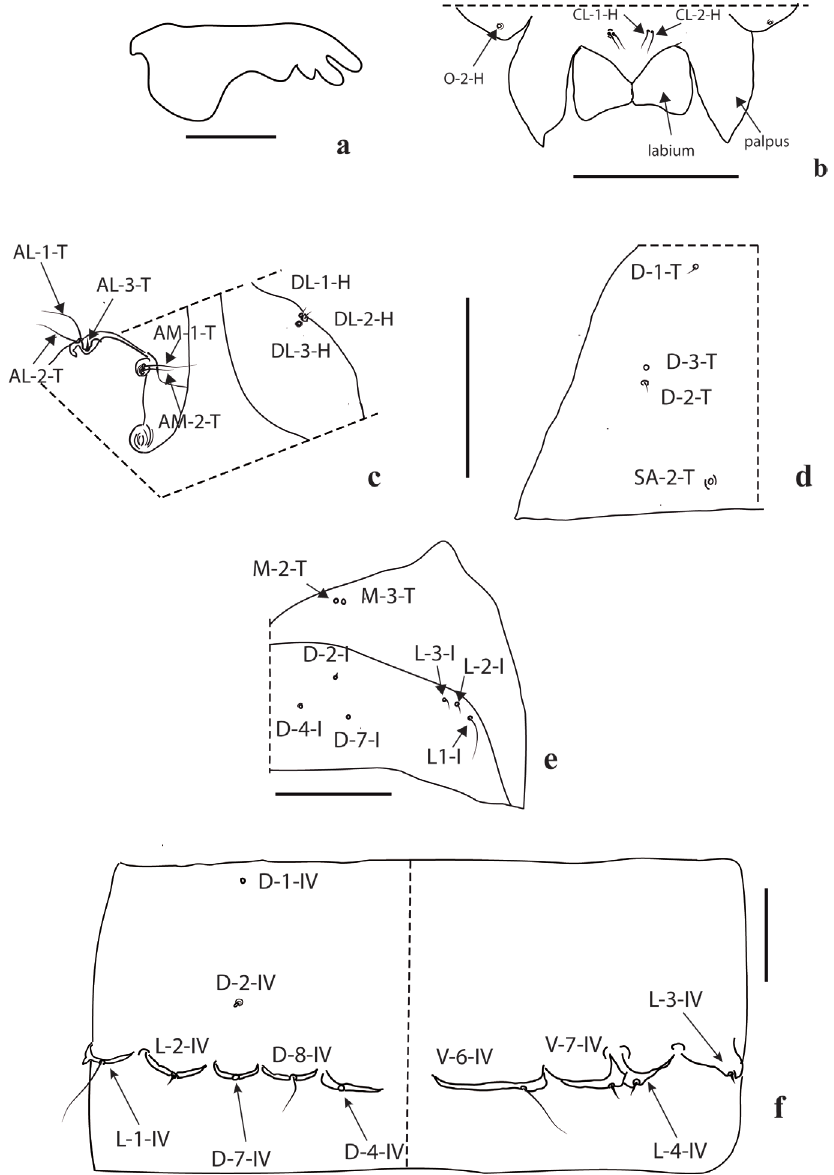
Figure 5 - Dasyhelea flavifrons Guérin-Méneville, a ) larva, b-f ) female pupa. a ) mandible; b ) mouthparts and clypeal/labrals and ocular sensillum (ventral view); c ) cephalothoracic sensilla; d ) dorsal sensilla; e ) metathorax and tergite 1; f ) segment 4. Anterolateral sensilla (AL-1-T, AL-2-T, AL-3-T); Anteromedial sensilla (AM-1-T, AM-2-T); clypeal/labral sensilla (Cl-1-H, Cl-2-H); dorsolateral cephalic sclerite sensilla (Dl-1-H, Dl-2-H, Dl- 3-H); dorsal setae (D-1-T, D-2-T, D-3-T); methatoracic sensilla (M-2-T, M-3-T); ocular sensillum (0-2-H); segment 4 sensilla (D-1-IV, D-2-IV, D-4-IV, D-7-IV, D-8-IV, l-1-IV, l-2-IV, l-3-IV, l-4-IV, V-6-IV, V7-IV); supraalar sensillum (SA-2-T); tergite 1 sensilla (D-2-I, D-4-I, D-7-I, l-1-I, l-2-I,